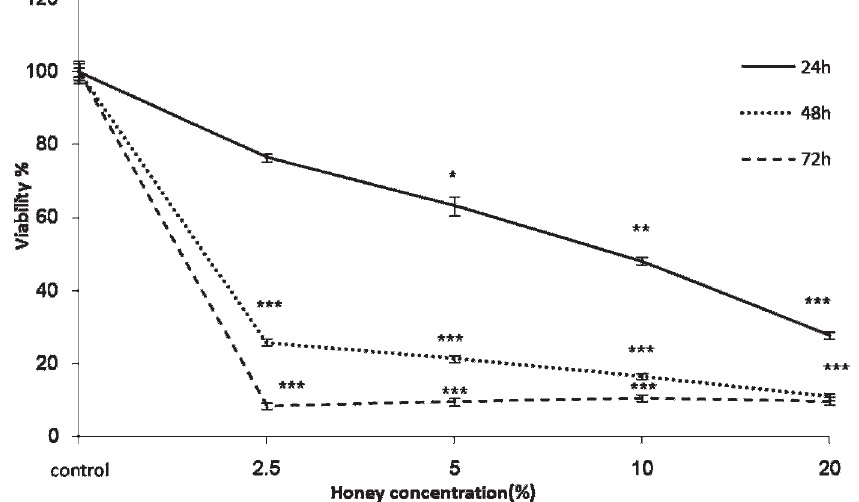
Figure 1 - Effect of honey on cell viability of PC-3 cells. Cells were treated with different concentrations of honey for 24, 48, and 72 hours. Viability was quantitated by MTT assay. Results are mean ¡ SEM. *** indicates p , 0.001 at different time points compared to controls.